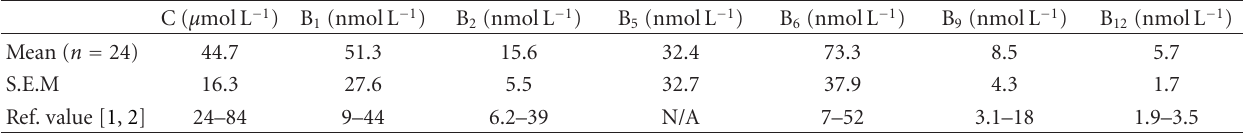
Table 6: Mean concentration of individual water-soluble vitamins ( ± SEM) in plasma samples obtained from 24 study participants. Elevate variability in individuals’ vitamin levels may explain high S.E.M.s in the case of B 1 , B 5 and B 6 .